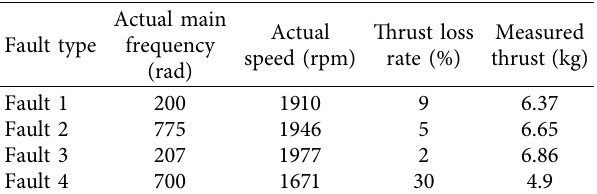
Figure 13: Relationship between PWM and motor speed. Table 2: Propeller thrust